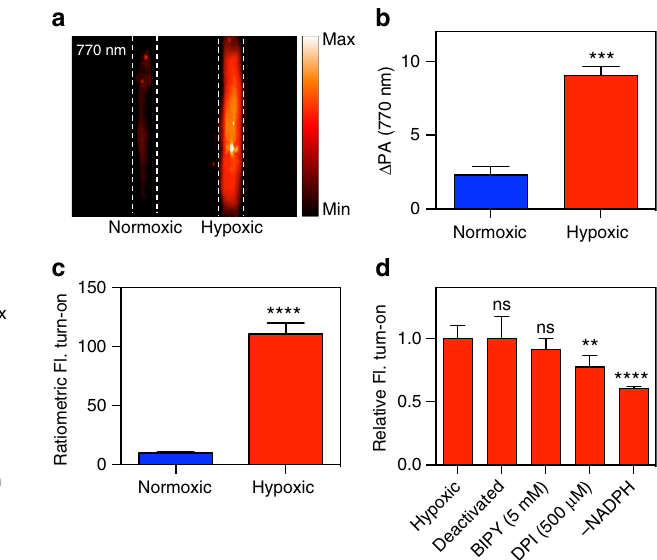
Fig. 3 Photophysical characterization of HyP-1 and red-HyP-1. a Normalized absorbance (dashed) and emission (solid) spectra of HyP-1 (blue) and red- HyP-1 (red). b PA spectra of HyP-1 and red-HyP-1. PA images of HyP-1 and red-HyP-1 solutions (10 μ M in 0.1 M potassium phosphate buffer (pH 7.4) with 50% EtOH co-solvent) in tissue-mimicking phantoms were obtained, and the mean PA signal corresponding to each compound was plotted as a function of wavelength. Results are presented as mean ± SD ( n = 3). c PA signal corresponding to various concentrations of red-HyP-1. d PA image (770 nm) of HyP-1 and red-HyP-1 solutions (10 μ M in 0.1 M potassium phosphate buffer with 50% EtOH co-solvent) in tissue-mimicking phantom. Dashed lines indicate positioning of FEP